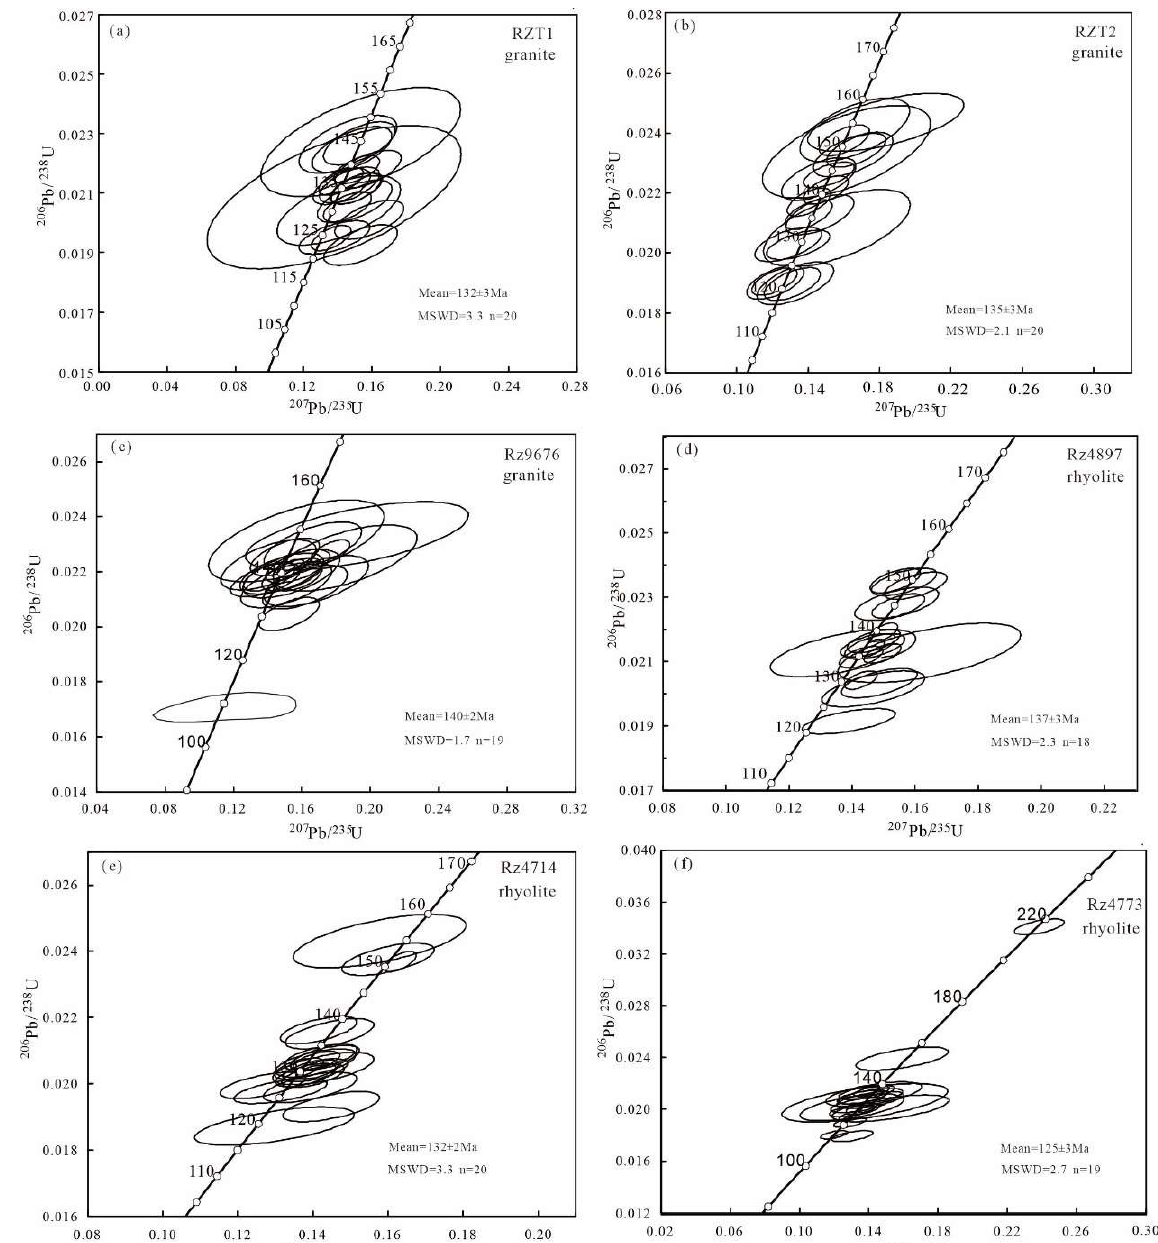
Figure 3. Concordia diagrams of the Early Cretaceous granite and rhyolite from the Badaguan area. ( a–c ) are granites; ( d–f ) are rhyolites;